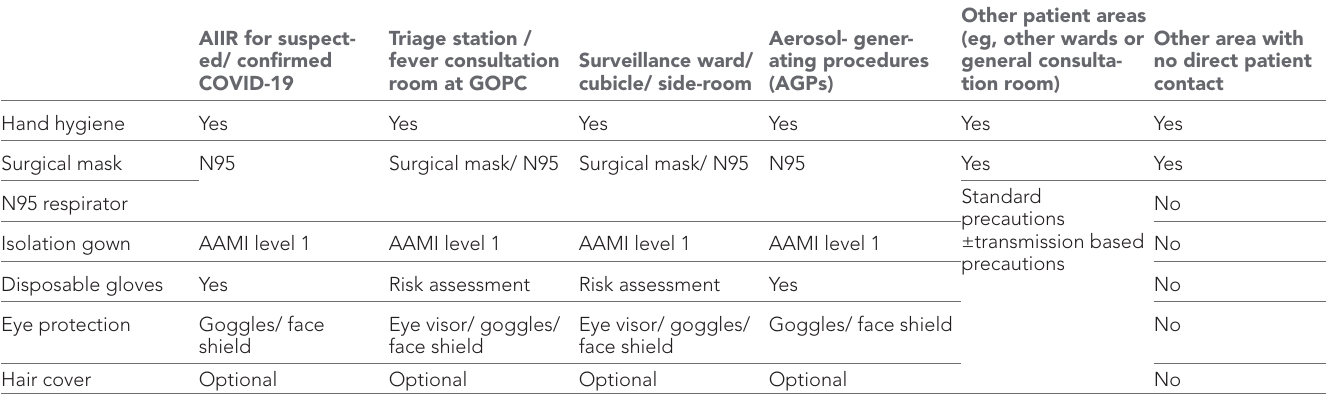
Table 1 Recommended PPE in different settings by Hospital Authority in Hong Kong (updated on 18 Feb 2020) AIIR for suspect- ed/